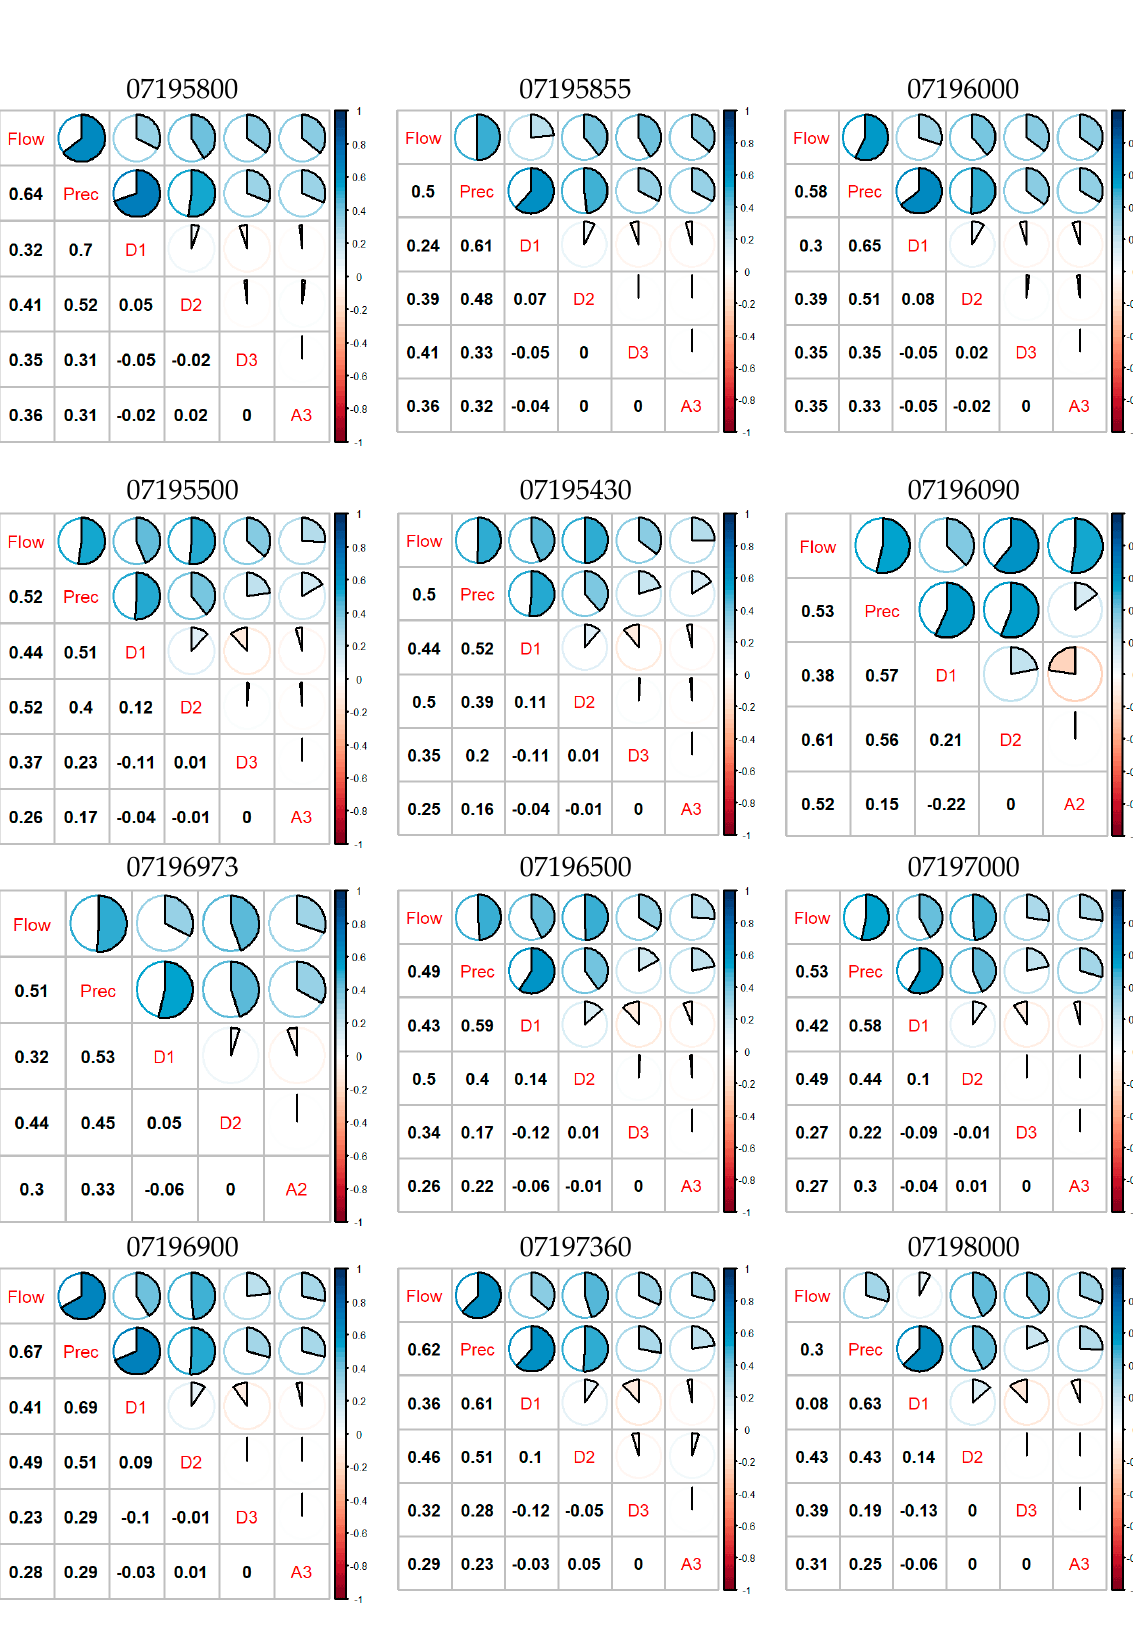
Figure 5. Correlation coefficient matrices of input variables in the SWAT − WSVR model (Note: ‘Prec’ denotes precipitation).